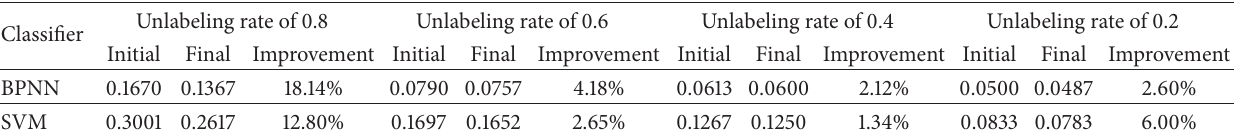
Table 8: Comparative diagnosis results of SVM and BPNN in Case